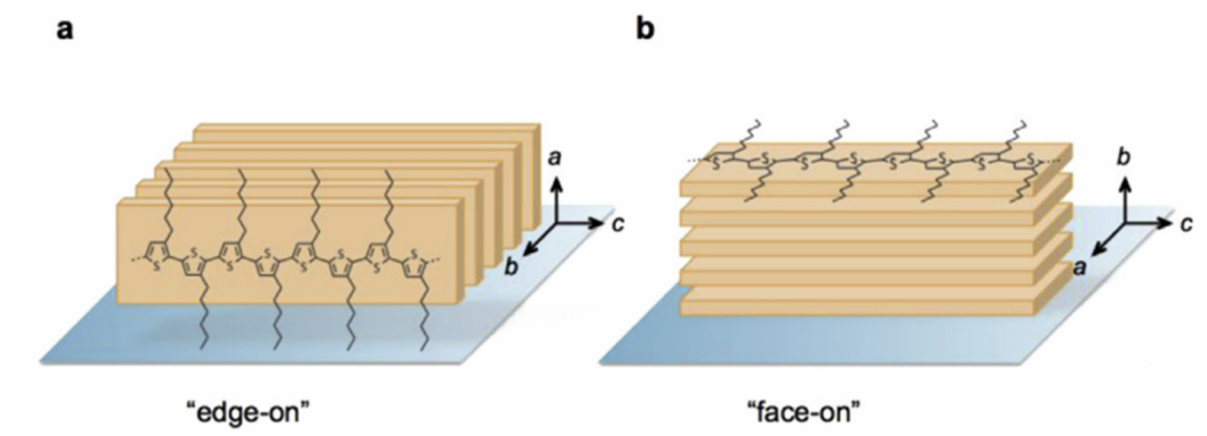
Figure 14. Schematic representation of ( a ) edge-on and ( b ) face-on orientations of semiconduc- tor backbone with respective to the substrate surface. Reprinted with permission form ref. [114]. Copyright 2015